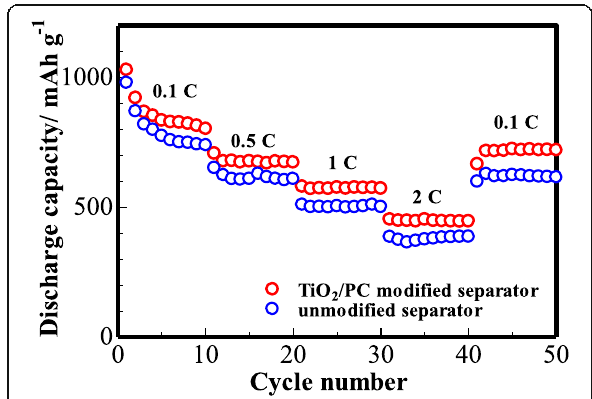
Fig. 11 The rate performance of the cell (with unmodified and TiO 2 / PC-modified Celgard 2400 separator) at various current densities